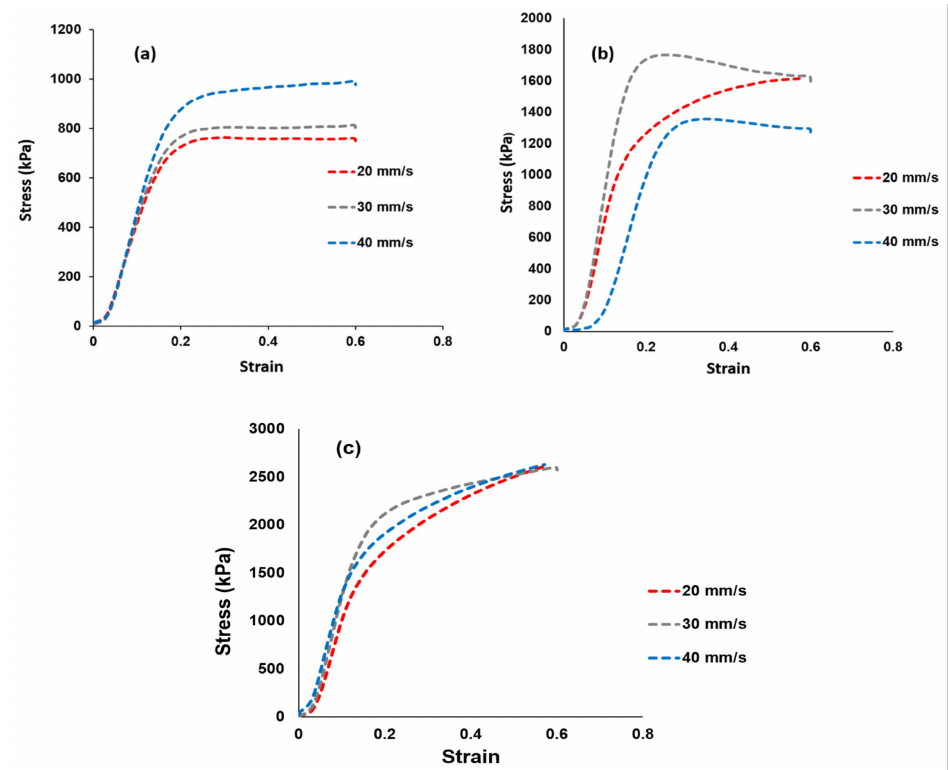
Figure 6. Mechanical tensile tests results of ( a ) Nafion ® 117 membrane and ( b ) Nafion ® /ZrP and ( c ) Nafion ® / S -ZrO 2 nanocomposite membranes shows stress versus strain ratio